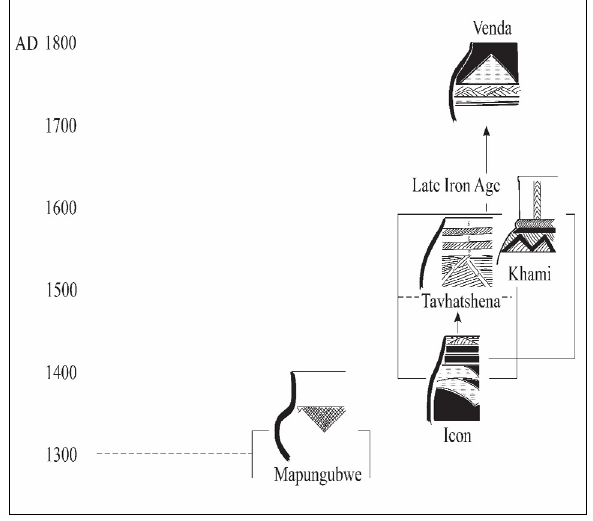
Figure 2: Ceramic sequence associated with Venda origins.